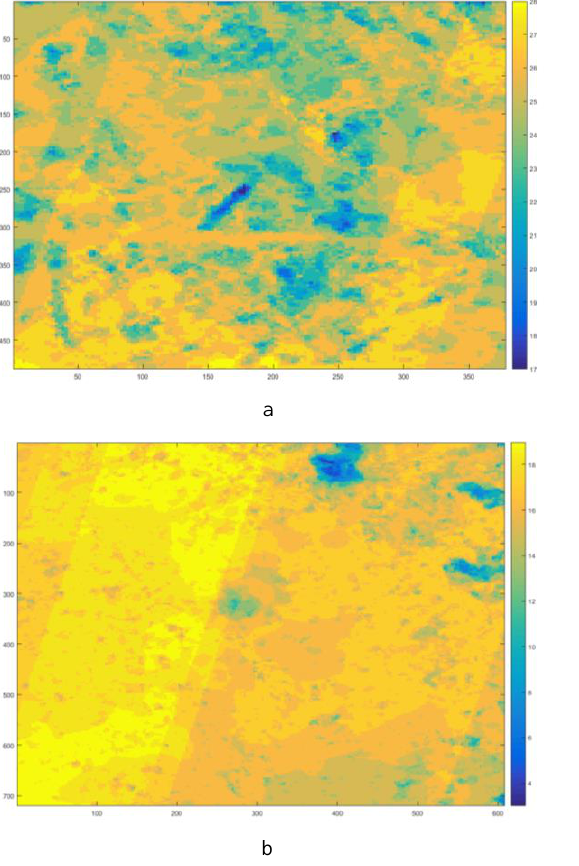
Figure 3. The STKN of ASTER GDEM in a) Bomehen study area, b) Tazehabad study area